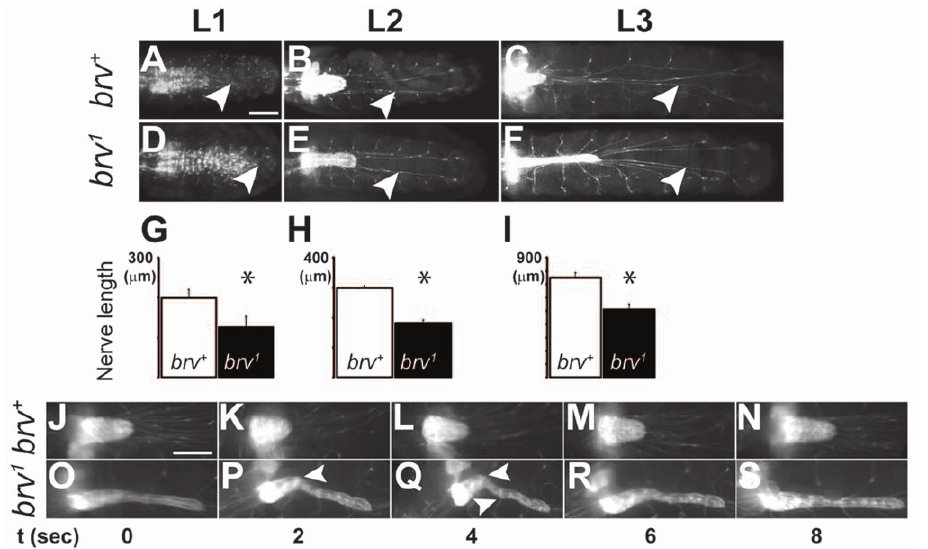
Figure 6. brv mutant larvae display shorter peripheral nerves. Representative pictures of L1, L2 and L3 larval brains from brv + (A, B, C) and brv 1 mutants (D, E, F) expressing Nrv2-GAL4;UAS-GFP (S65T) to visualize the peripheral nerves. White arrowheads indicate the most posterior projecting and longest peripheral nerves used for these measurements. Histograms (G, H, I) compare the average lengths of the longest peripheral nerves during L1 (G), L2 (H) and L3 (I) larva between wild-type and brv 1 mutants. The peripheral nerves are significantly shorter in brv 1 mutants (*: p , 0.0001). (J–S) Representative frames, taken from time-lapse recordings of wandering larva expressing Nrv2-GAL4; UAS-GFP (S65T) , display the VNC during one full cycle of a larval contraction and expansion during locomotion. A brv + (J–N) and brv 1 larva (O–S) is shown. Ripples (arrowheads in P, Q), indicative for relaxation from tension, were detected only in VNC of brv 1 mutants but not in brv + (J–N). Bar: 100 m m. A time line (in sec) is shown below panels J–S.